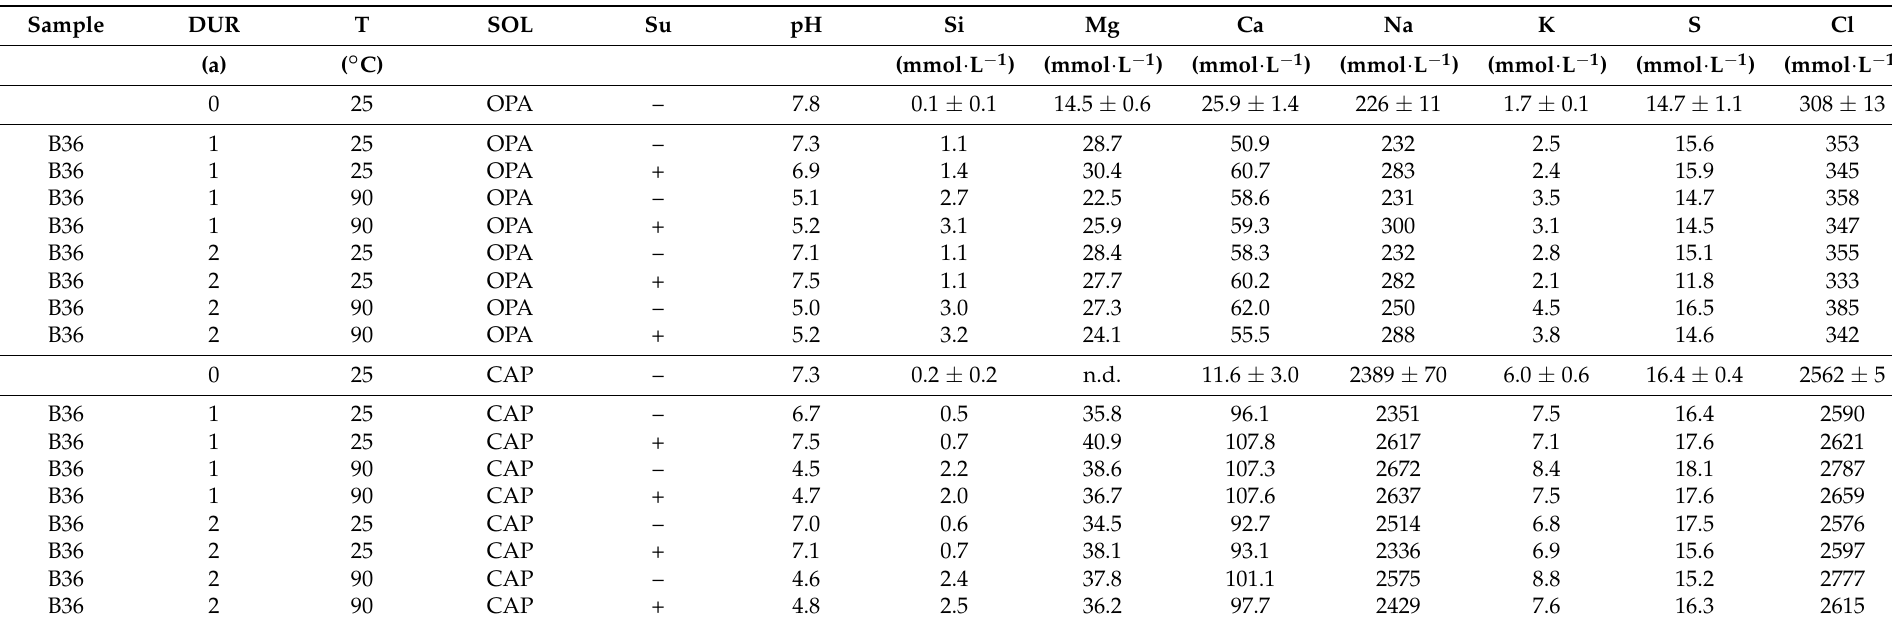
Table 8. Solution chemistry of B36 bentonite batches and measured pH values (n.d. = not determined due to the complete adsorption of the solution by smectite), DUR: duration, SOL: solution, Su: